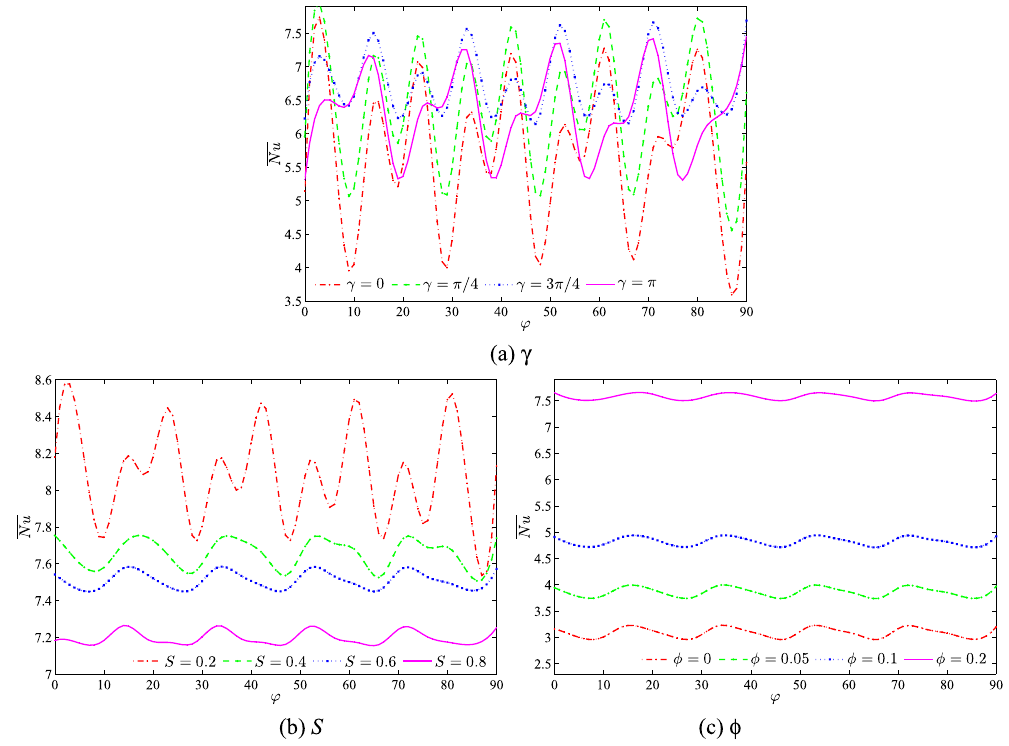
Figure 13. Values of Nu interfaces with ϕ for ( a ) different γ , ( b ) different S and ( c ) different φ at Ra bf = 10 5 , Da = 10 − 4 and ε = 1.